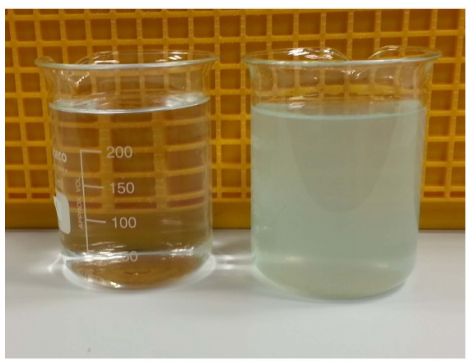
Figure 6. “Blue water” sample, before ( right ) and after filtration ( left ) with 0.45-micron pore-size nylon